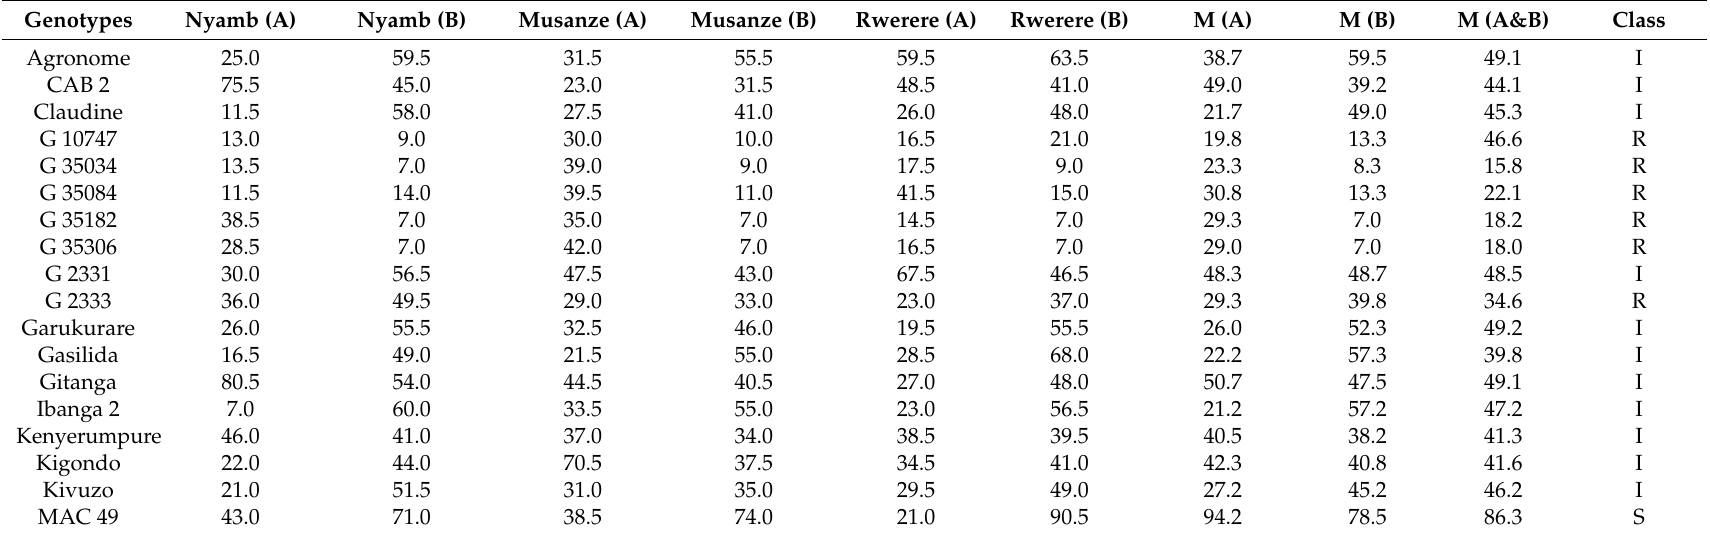
Table 5. Average RAUDPC of 36 climbing bean genotypes tested in six environments in